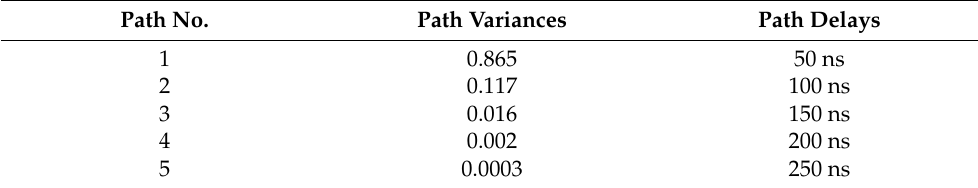
Table 1. Delay and power distribution for multipath channels. Path No.